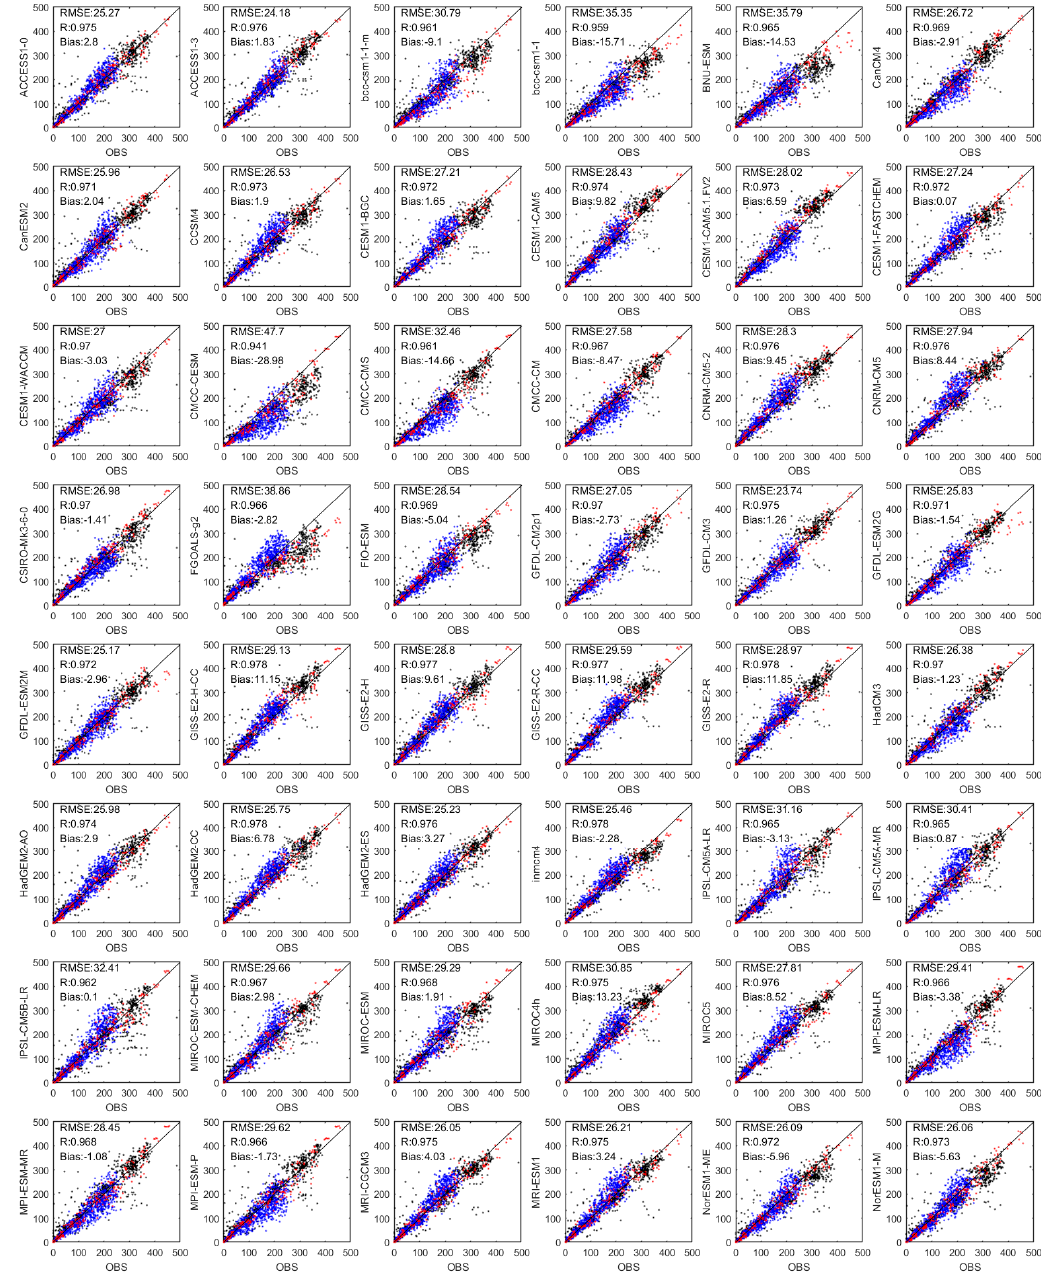
Figure 2. Scatterplots of the monthly surface incident shortwave radiation ( SSR ) observations from 44 sites (red dots: surface observations from BSRN sites, black dots: surface observations from GC-NET sites, blue dots: surface observations from GEBA) and individual general circulation models (GCMs) simulations from 2000 to 2005 (in units of W m − 2 ).